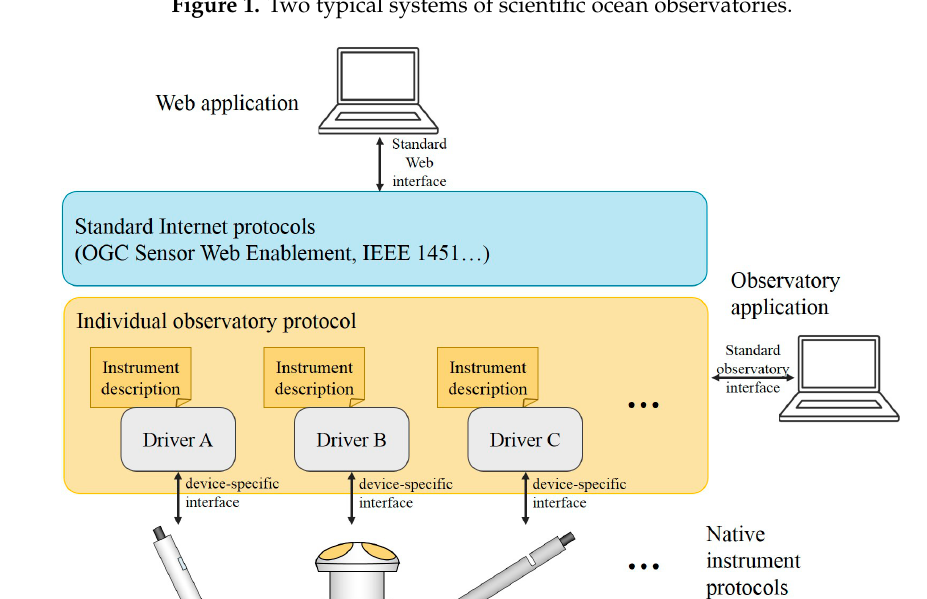
Figure 2. Interoperable instrument protocol layers [5] .